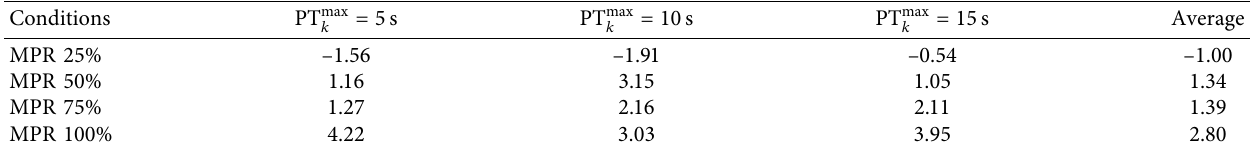
Table 10: Travel time improvements of BRT vehicles based on signal priority